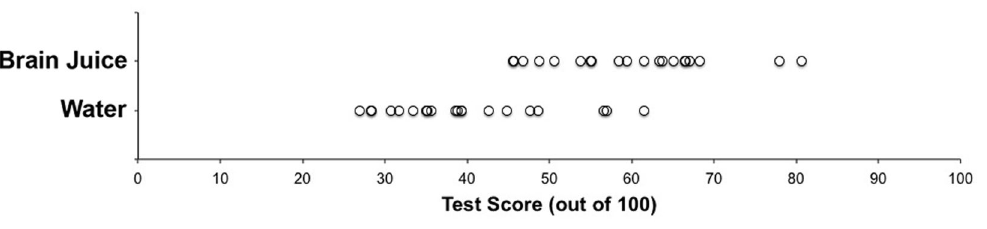
Figure 1. Example version of a graphical representation of the data shown to participants in Experiment 1 (Condition 4 in Table